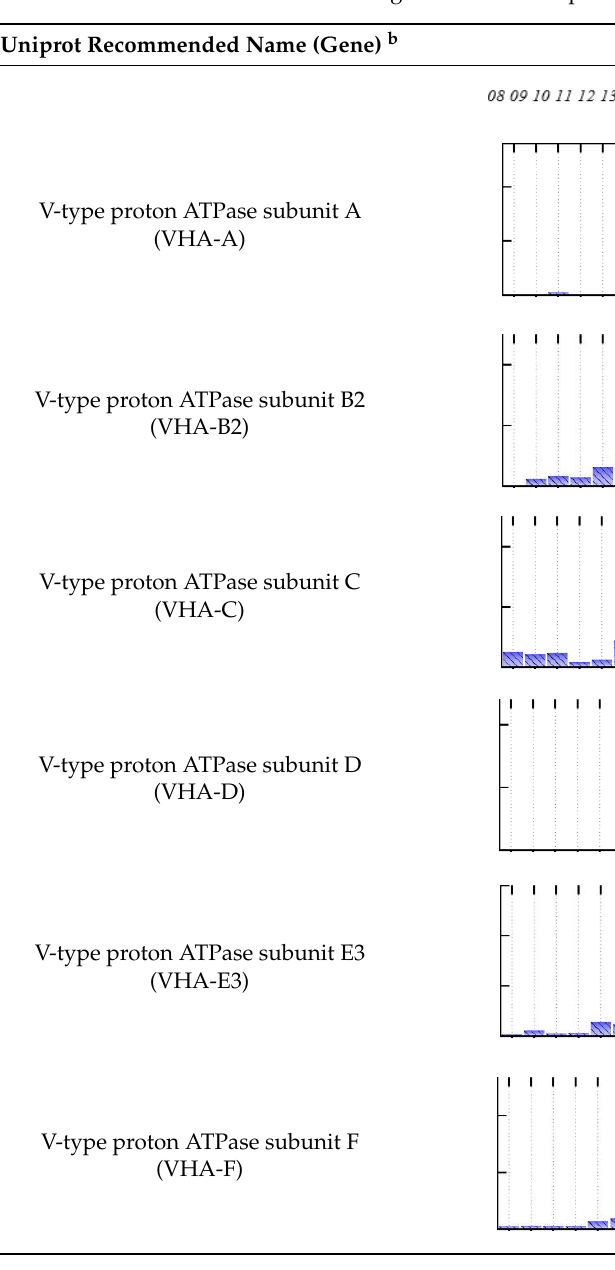
Table 2. Digital western FFE profiles of tonoplast marker proteins a .